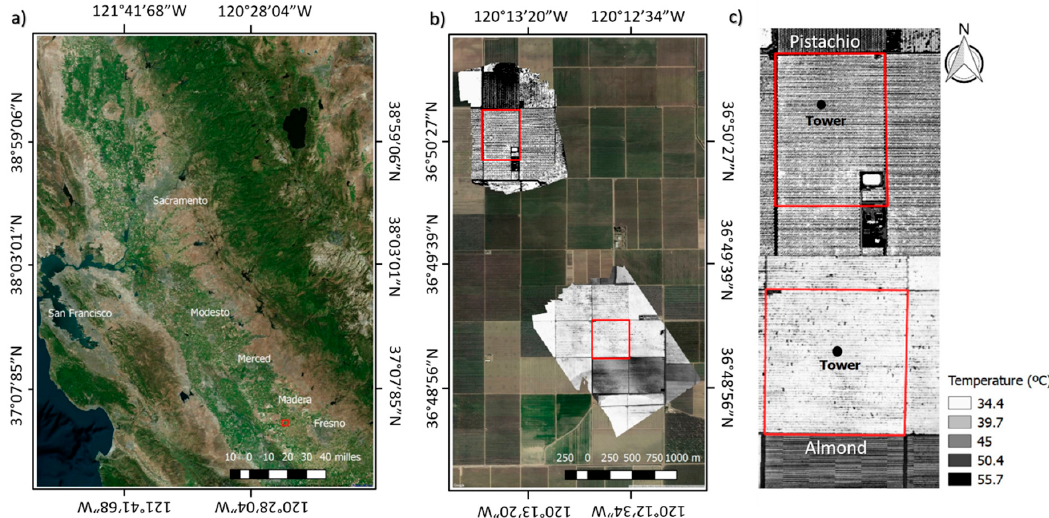
Figure 1. Study area (red squares) shown as: ( a ) true color image of Central Valley (California) from Google Earth; ( b ) thermal mosaic of the almond (36°49’12.59”N; 120°12’38.30”W) and pistachio (36°50’26.68”N; 120°13’31.80”W) orchard acquired on the 11 th August 2016, and ( c ) detailed thermal mosaic of both orchards indicating the location of the flux towers.